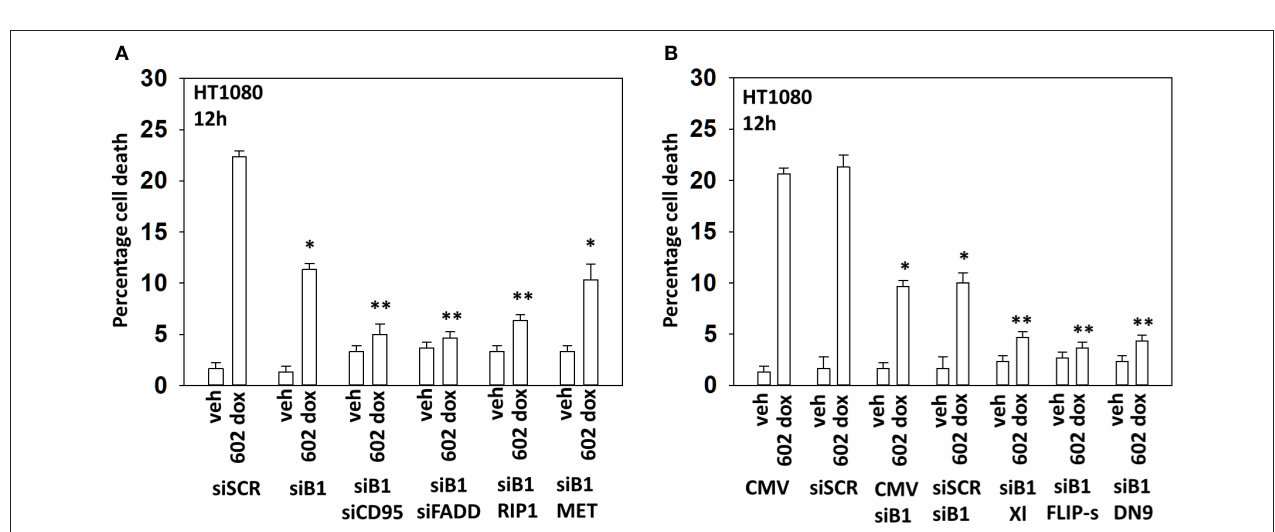
FIGURE 7 | In the absence of autophagy, GZ17-6.02 -induced killing is mediated via CD95-FADD. (A) HT1080 human sarcoma cells were transfected with a scrambled siRNA (siSCR) or with an siRNA to knock down the expression of Beclin1, and in parallel, siBeclin1 transfected cells were transfected to knock down the expression of the indicated proteins. Twenty-four hour afterwards, cells treated with vehicle control or with [GZ17-6.02 (2 µ M final curcumin) + doxorubicin (200nM)] in combination for 12h. Cells were isolated, and viability determined by a trypan blue exclusion assay ( n = 3 + /–SD). * p < 0.05 less than vehicle control; ** p < 0.05 less than corresponding value in siBeclin1 alone. (B) HT1080 cells were transfected with a scrambled siRNA (siSCR) or with an siRNA to knock down the expression of Beclin1, and in parallel, cells were transfected with an empty vector plasmid or with plasmids to express BCL-XL, c-FLIP-s or dominant negative caspase 9. Twenty-four hour afterwards, cells treated with vehicle control or with [GZ17-6.02 (2 µ M final curcumin) + doxorubicin (200nM)] in combination for 12h. Cells were isolated, and viability determined by a trypan blue exclusion assay ( n = 3 + /–SD). * p < 0.05 less than vehicle control; ** p < 0.05 less than corresponding value in siBeclin1